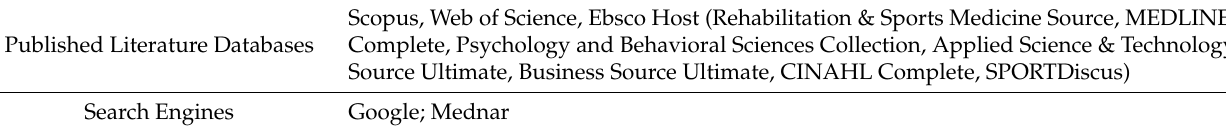
Table 1. Summary search